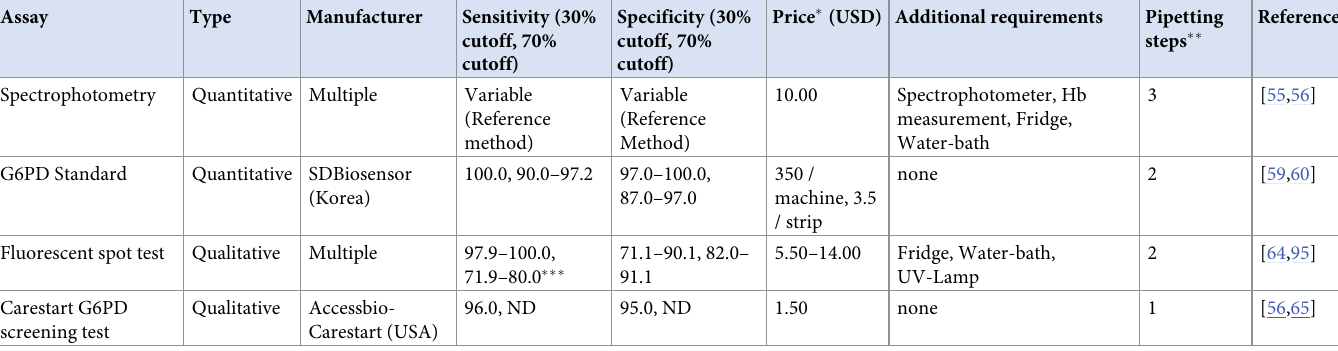
Table 2. Glucose-6-phosphate dehydrogenase deficiency tests suitable for field use.